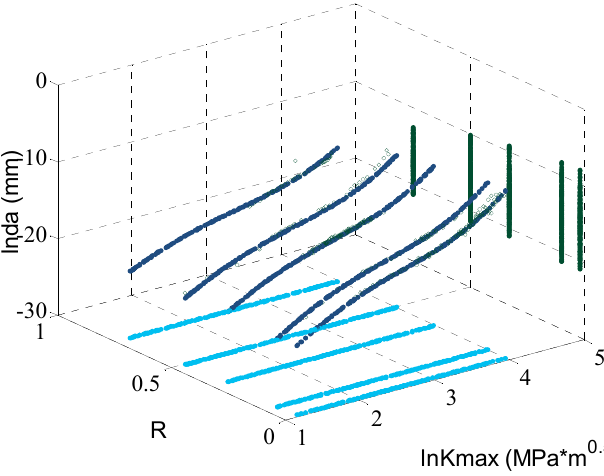
Figure 6. The fitting curves of ANN trained with all data.